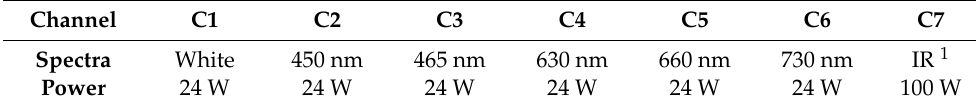
Table 1. Channels, spectral range and power per channel.